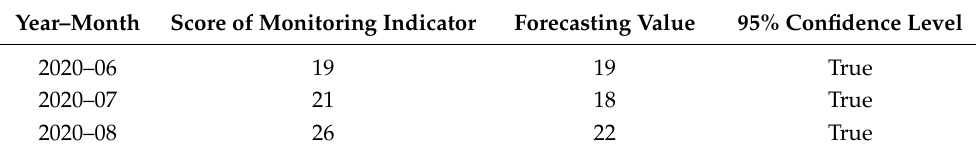
Table 2. Comparison of the predicted values of the monitoring indicator and the actual price. Score of Monitoring